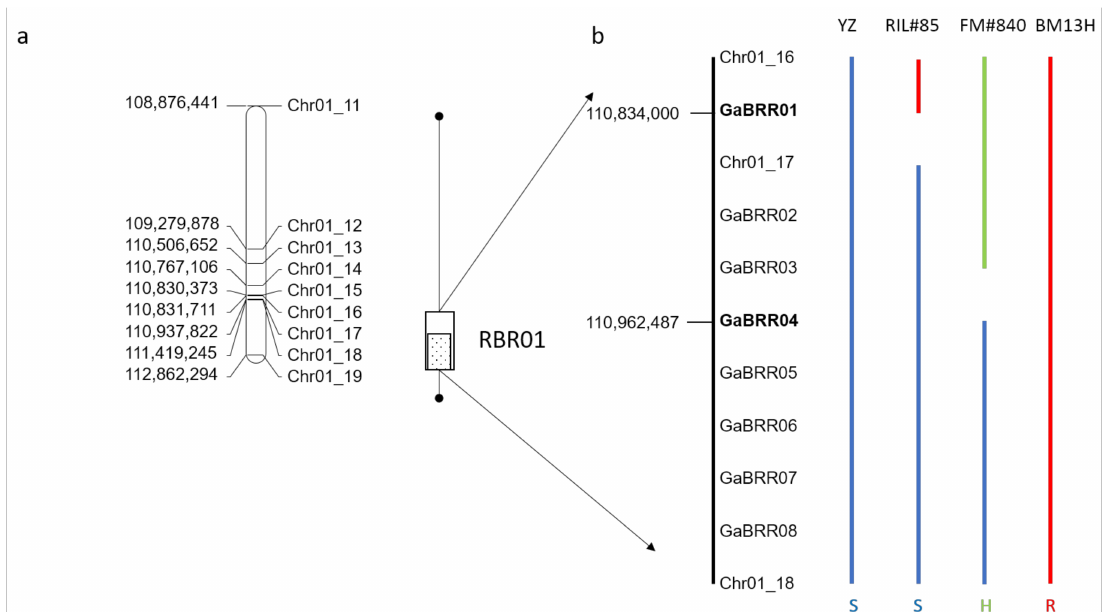
Figure 6. Mapping of the BRR resistance locus RBR01. ( a ) Single marker analysis associated resistance with markers Chr01_11 to Chr01_19 (line with closed circles at end), and a single QTL was detected between markers Chr01_17 to Chr01_18 (dotted box). Scoring the phenotype as a simple trait indicated the interval was between Chr01_16 and Chr01_18 (open box). ( b ) Fine mapping of the region with key recombinants reduced the interval to between GaBRR01 and GaBRR04 markers (bold), S = susceptible (Blue), H = Heterozygous (green) and R- resistant (red).